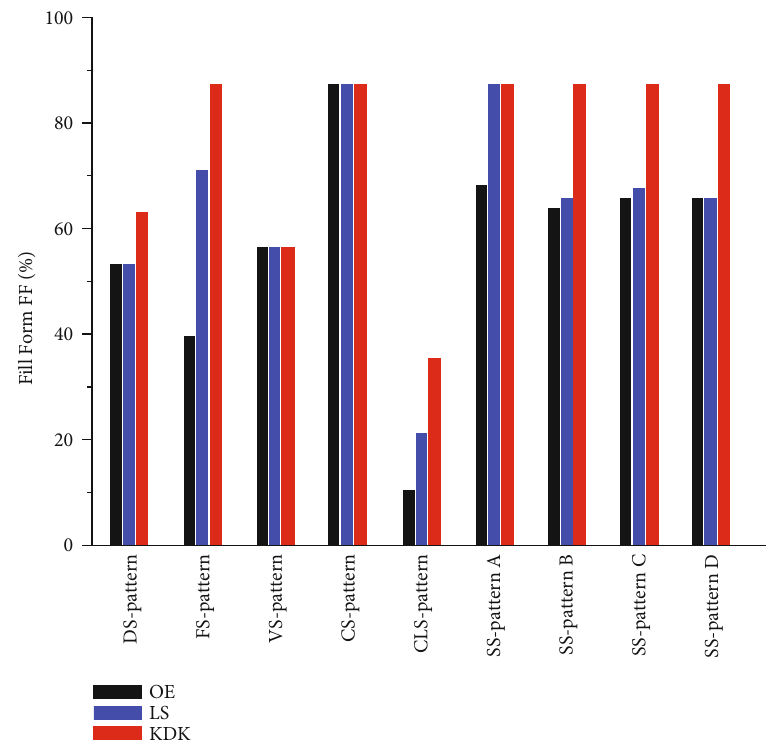
Figure 20: E ff ects of partial shading patterns on fi ll factor. Table 4: Parameters of PV cell (1000W/m 2 , 25 ° C). Cell parameters